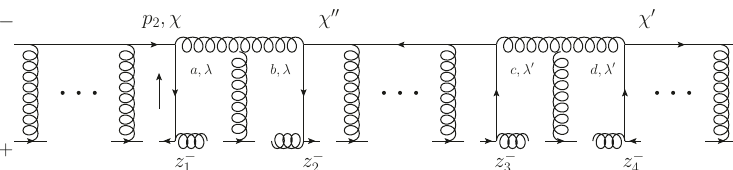
Figure 4. The diagram for a double quark exchange following the double anti-quark exchange, with two quark field operators or two anti-quark field operators inserted instead of a quark and anti-quark field operator pair from figure 2 inserted